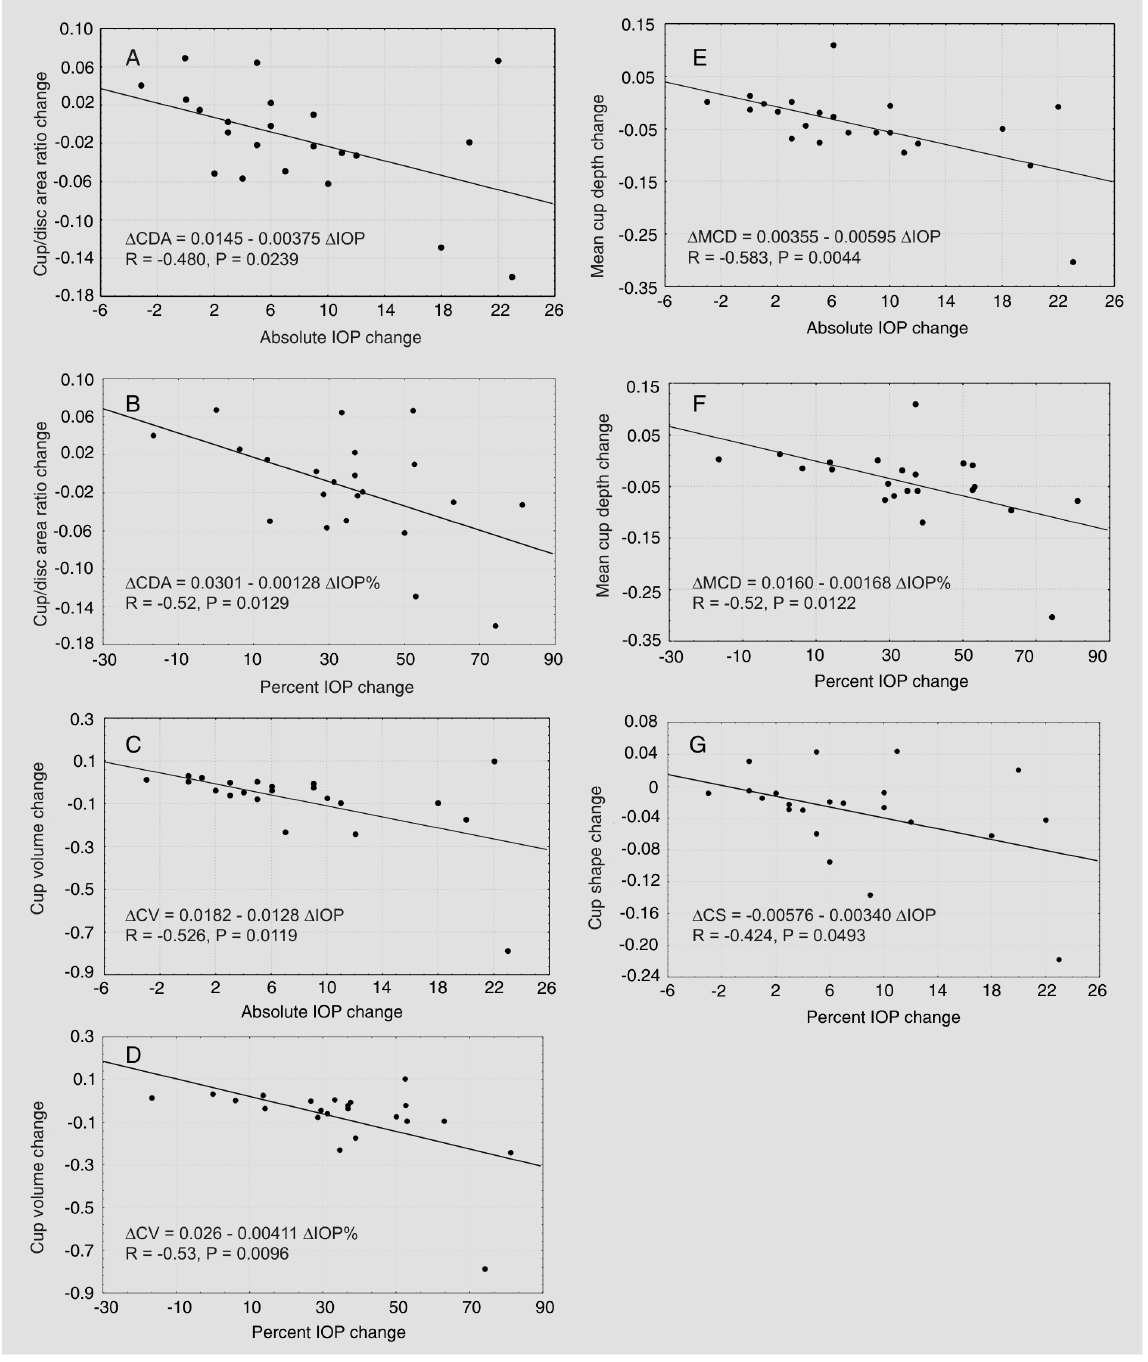
Figure 1. Effect of the reduction of intraocular pressure on optic nerve parameters after trabeculectomy. A , cup/disc area (CDA) ratio change and absolute interocular pressure (IOP) reduction; B , CDA ratio change and percent IOP reduction; C , cup volume (CV, mm 3 ) change and absolute IOP reduction; D , cup volume (mm 3 ) and percent IOP reduction; E , mean cup depth (MCD) change (mm) and IOP reduction; F , mean cup depth change (mm) and percent IOP reduction; G , cup shape (CS) change and absolute IOP reduction. Correlation coefficients were calculated by the method of